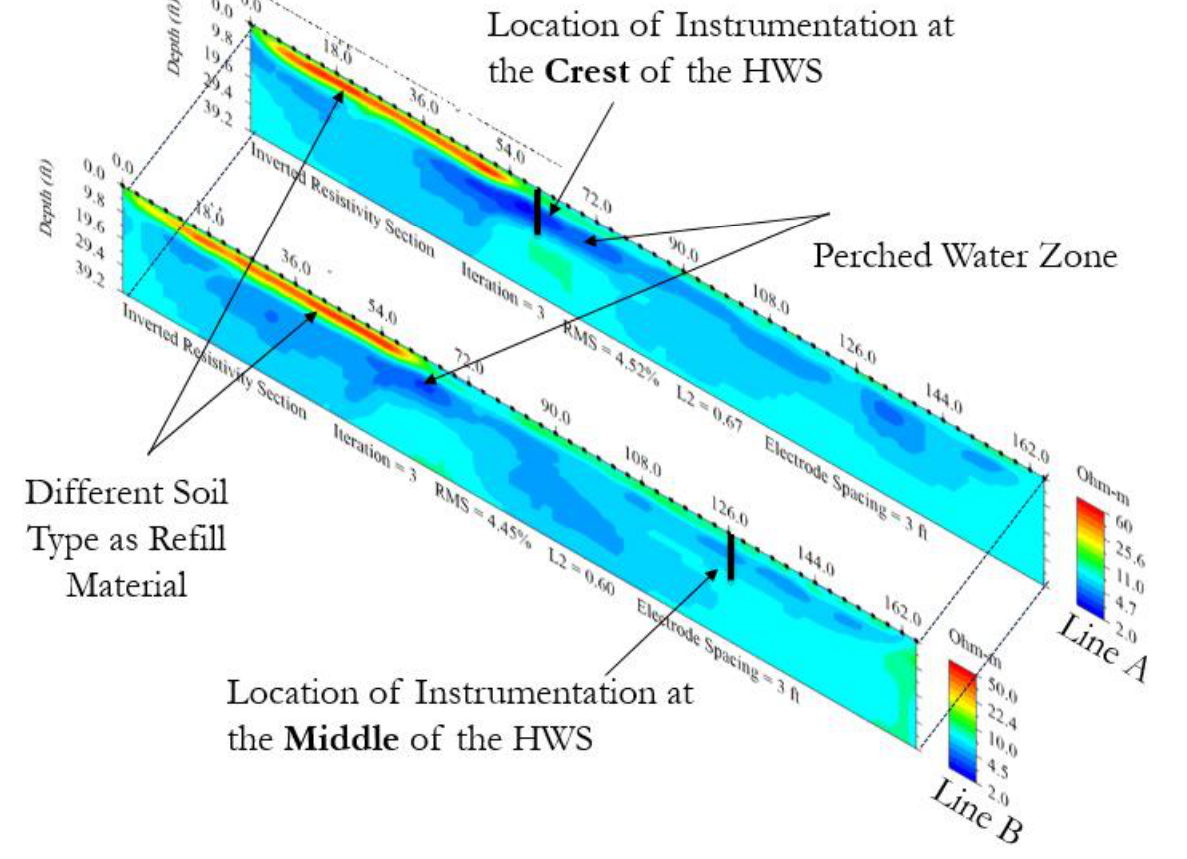
Figure 18. HWS 3, 2D ERI test profile at line A and at line B tested on 9 January 2021 (1 ft = 0.3 m).